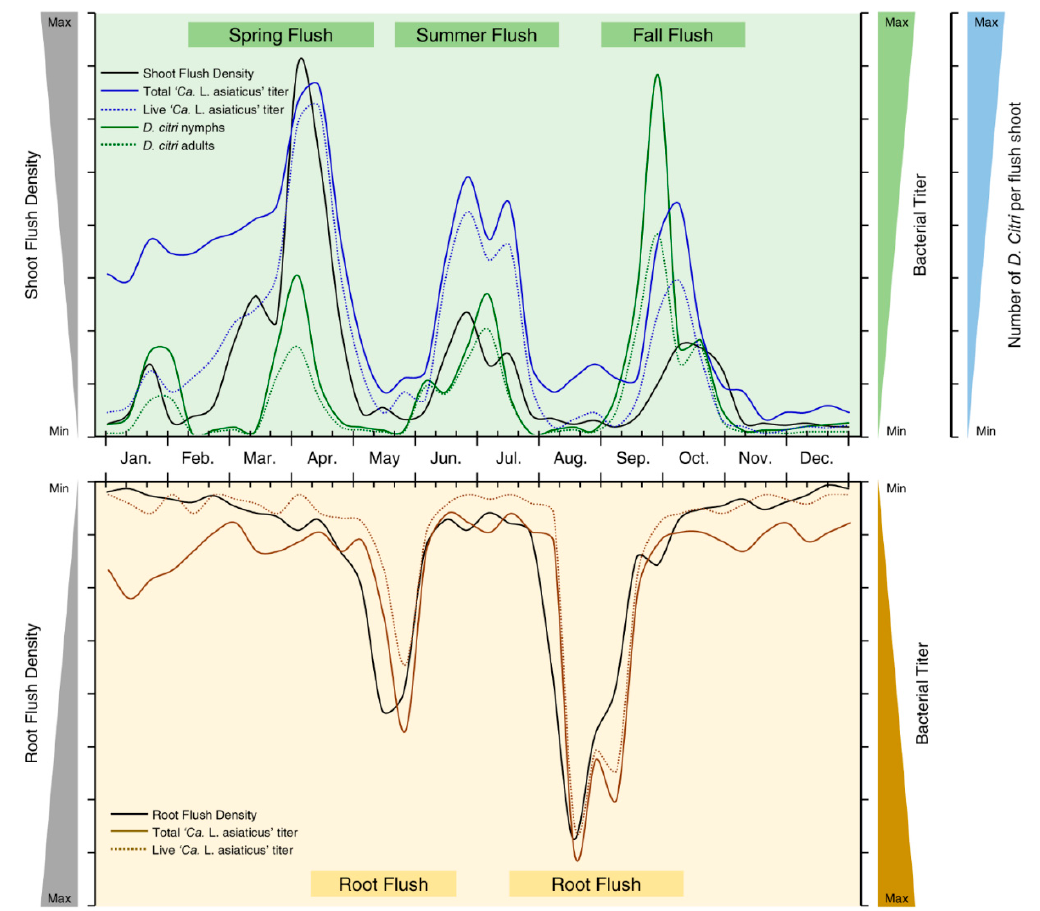
Figure 6. Population dynamics of ‘ Candidatus Liberibacter asiaticus’ and its insect vector, Asian citrus psyllid, Diaphorina citri (Hemiptera: Liviidae), in relation to the annual flushing cycles and root growth patterns of citrus trees in Florida. The data presented in this figure were adapted from previously published data by [138–152].